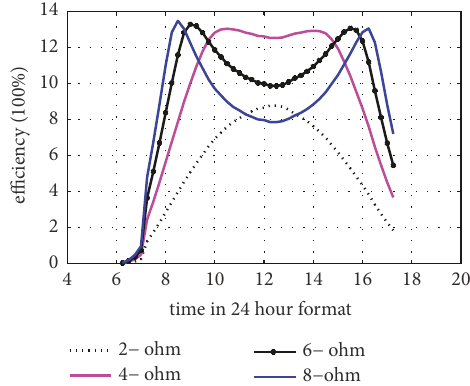
Figure 16: Hourly variation of efficiency of Kyocera 200GT PV module for different electric load under weather condition of January 1 st